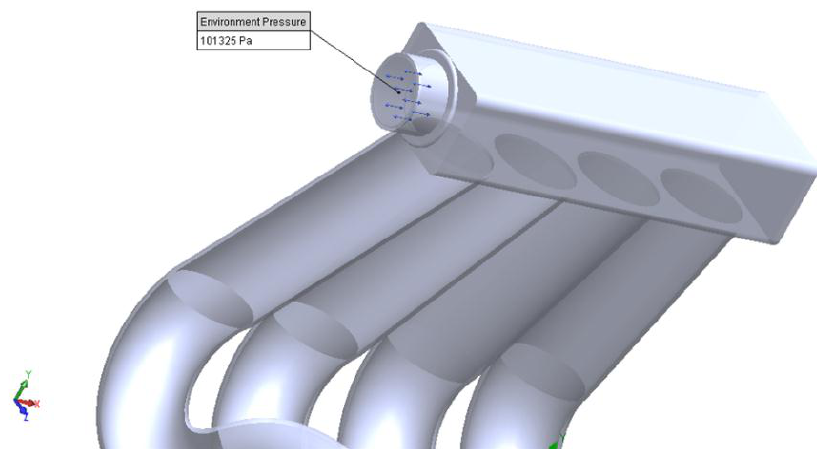
Figure 4. Boundary conditions on intake.